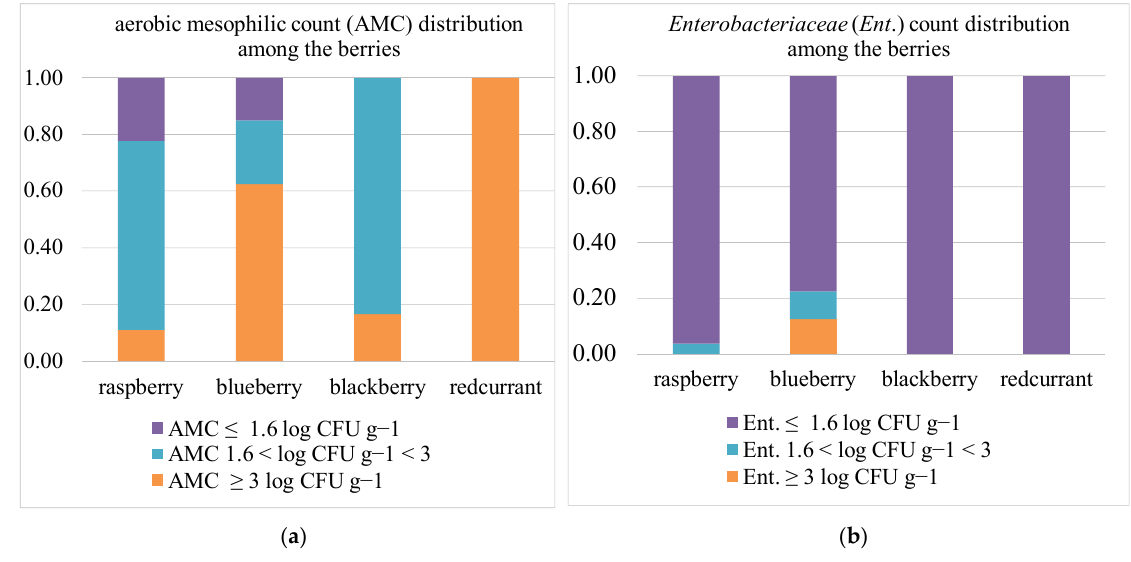
Figure 2. Microbiological analysis and distribution among berries: ( a ) aerobic mesophilic count (AMC); ( b ) Enterobacteriaceae ( Ent .).